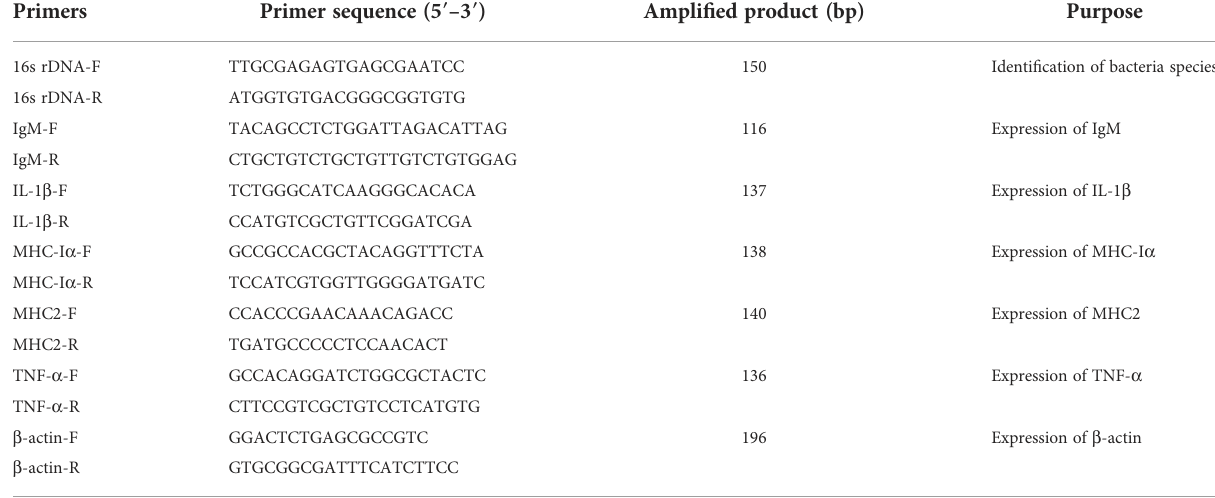
TABLE 1 Primers used in this study.